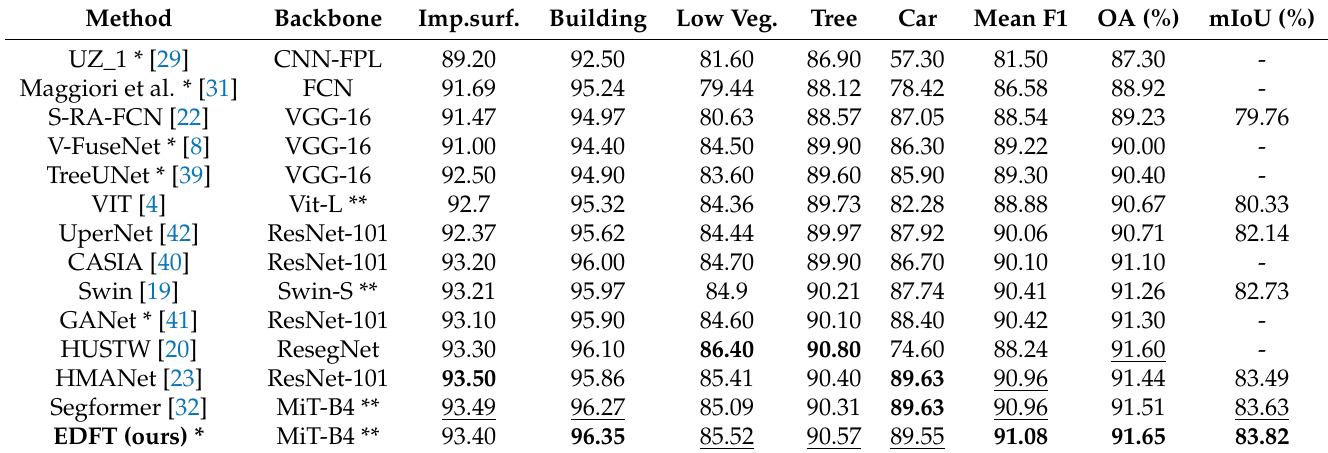
Table 1. Comparisons with the state-of-the-art on Vaihingen test set, where * represents the method employing DSM or nDSM, ** represents transformer backbone, and - represents missing data. The values in bold are the best and the values underlined are the second best.